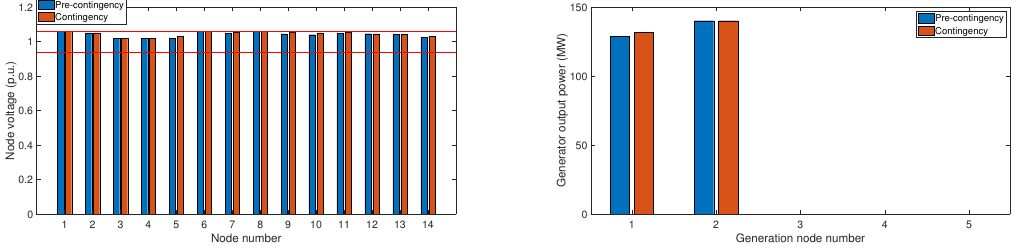
Figure 6. Voltage and power dispatched implementing the QCQP results in a power flow of the network prior to and after contingency of branch 10 (generation nodes are, respectively, 1, 2, 3, 6, and 8).